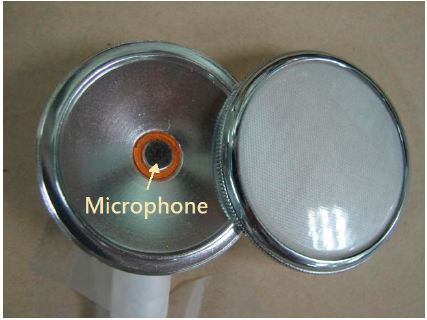
Figure 1. The hardware used to measure and record lung sounds and respiratory phase.